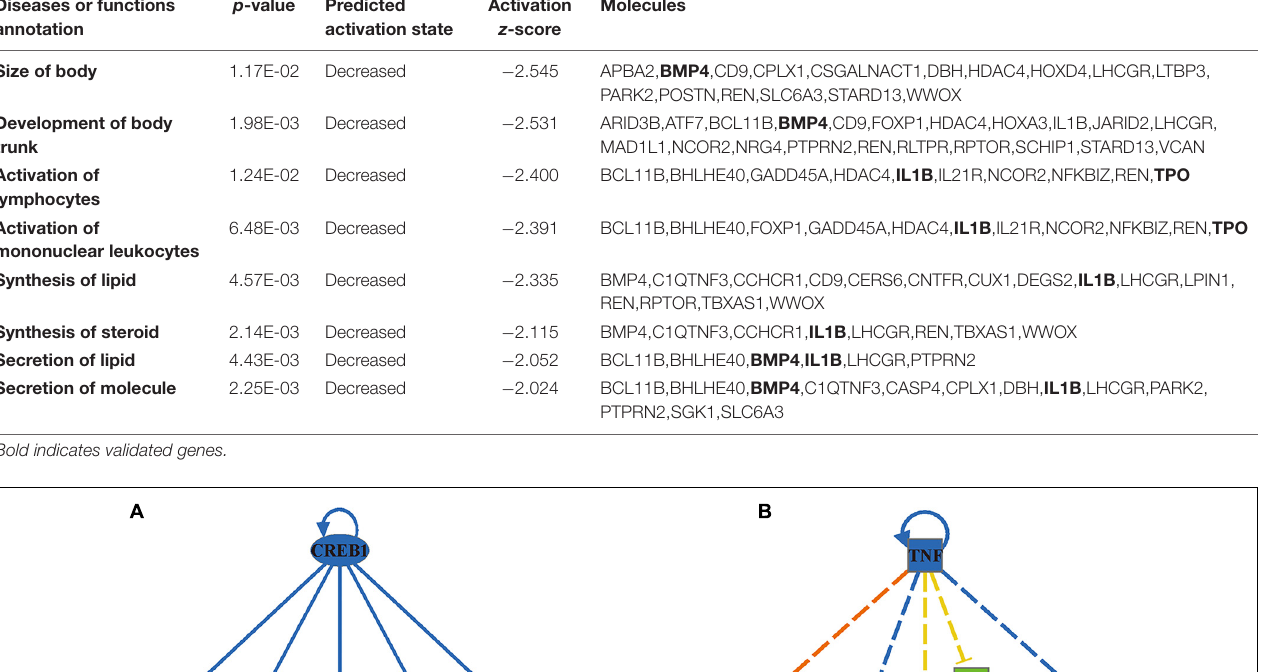
Frontiers in Cell and Developmental Biology |